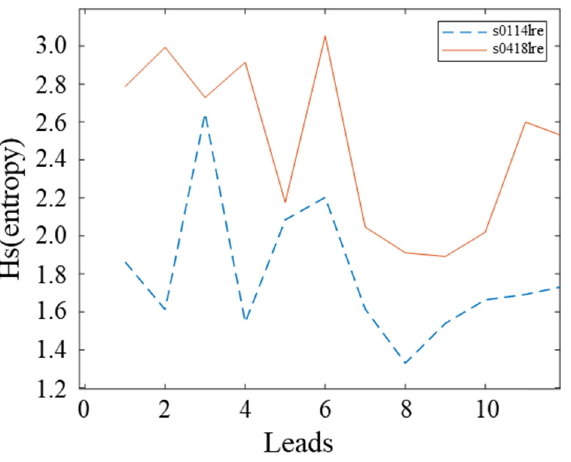
Figure 2. Comparison diagram of the signal information entropy of two examples.